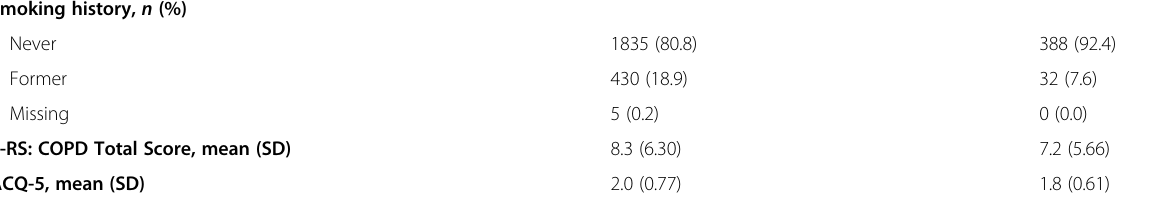
Table 1 Demographics and clinical characteristics in Phase 1 and Phase 2 (Continued)